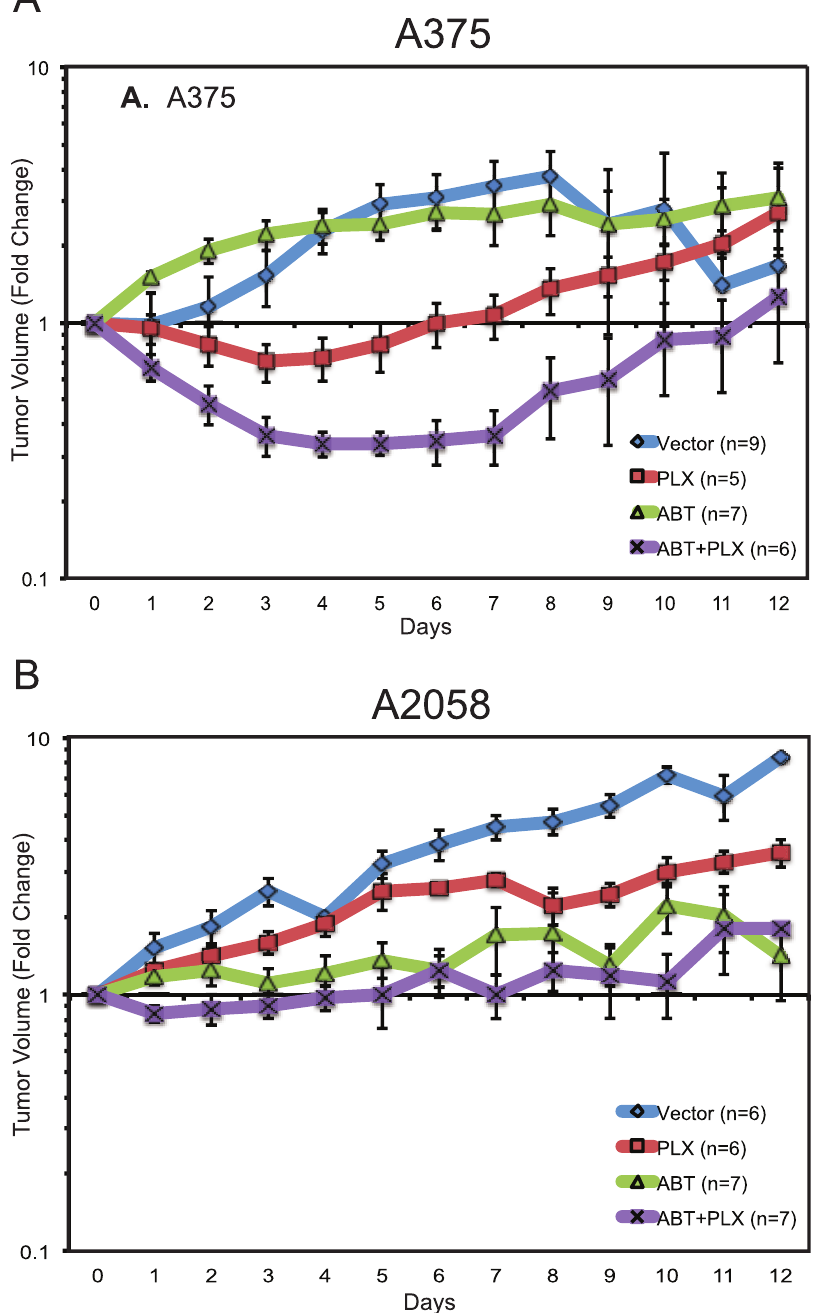
Figure 6. The effect of BH-3 mimetic treatment, BRAF inhibition, and their combination on tumor growth in BRAF V600E mutant xenografts. ( A ) A375 xenograft. ( B ) A2058 xenograft. PLX4720 was used as BRAF inhibitor and ABT-263 was used as BH3-mimetic. Both inhibitors were given to mice PO daily at 100 mg/kg [45] for 12 days according to treatment group. Mice were euthanized when tumors reached maximal allowed tumor volume. This occurred between days 9 and 12 for some but not all animals. Error bars represent standard error of the mean